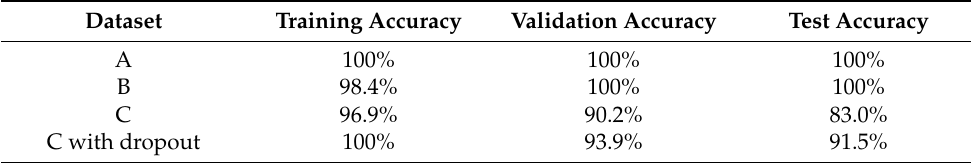
Figure 9. Test confusion matrices: ( a ) dataset A; ( b ) dataset B; ( c ) dataset C; ( d ) dataset C with dropout layer. Table 5. Performances for bearing fault detection using YAMNet and transfer